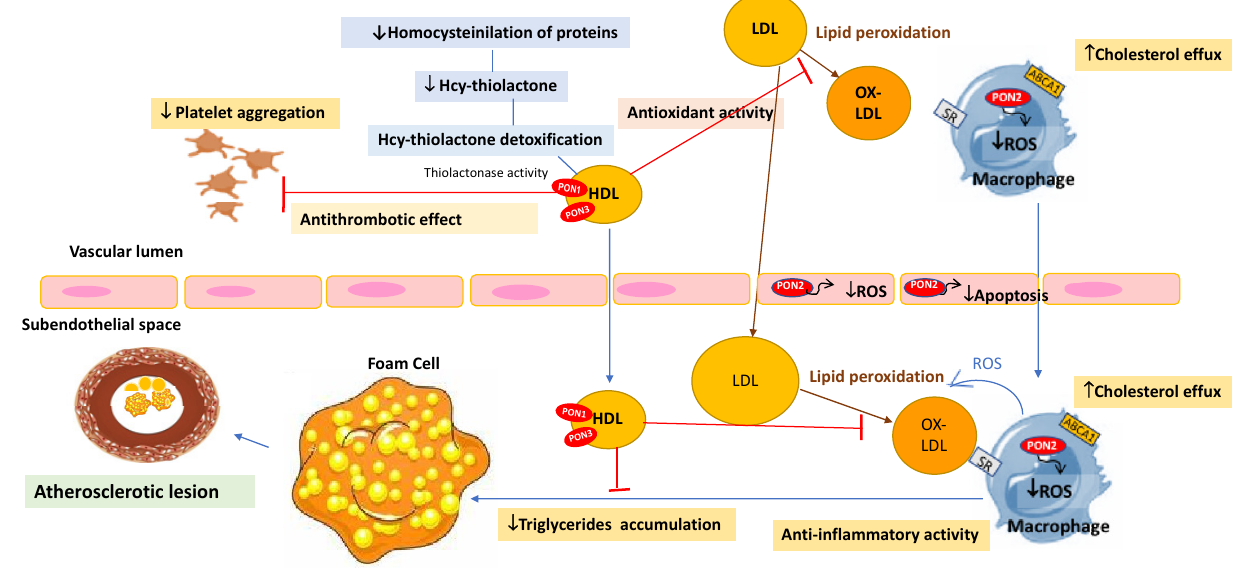
Figure 1. Pleiotropic antiatherogenic roles of PONs. Paraoxonase: PON; Paraoxonase 1: PON1; Paraoxonase 2: PON2; Paraoxonase 3: PON3; High-density lipoprotein: HDL; Oxidized low-density lipoprotein: Ox-LDL; Low-density lipoprotein: LDL; Reactive oxygen species: ROS. Phytochemicals are extracted from herbal plants worldwide. These molecules have